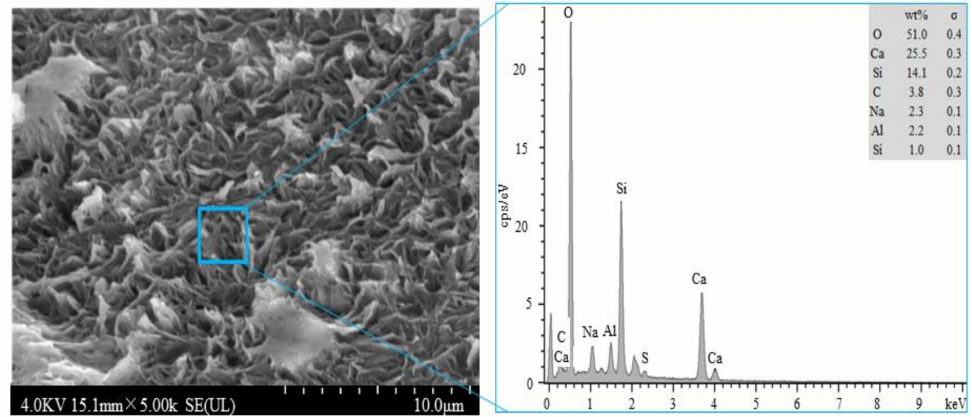
Figure 11. Scanning electron microscope energy dispersive spectroscopy (SEM–EDS) of the fly ash at 60